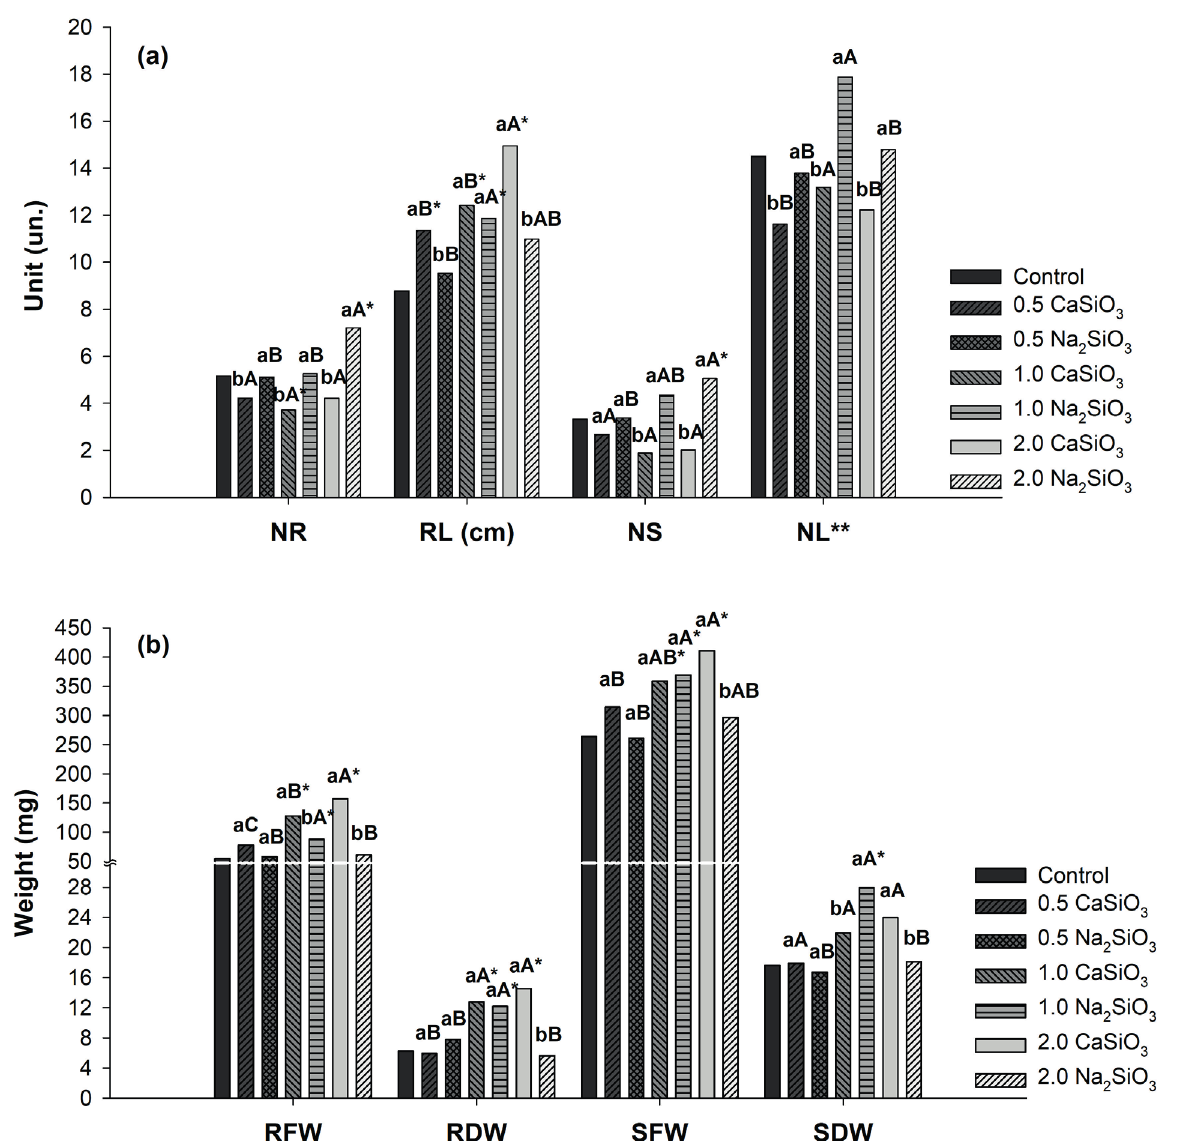
Figure 2 - Growth analysis in plants of B. zebrina as a function of different sources and concentrations (mg L -1 ) of silicates after 100 day of in vitro growth. (a) Number of roots (NR), root length (RL) in cm, number of shoots (NS) and number of leaves (NL); (b) Root fresh weight (RFW), root dry weight (RDW), shoot fresh weight (SFW) and shoot dry weight (SDW) in mg. Means followed by ‘*’ are different from the control by Dunnet’s multiple range test at 5% probability; lowercase letters refer to the unfolding of the sources within each concentration, the means with distinct lowercase letters are different by Tukey’s multiple range test at 5% probability; Capital letters refer to the unfolding of concentrations within each source, the means with distinct capital letters are different by Tukey’s multiple range test at 5% probability. ‘**’ Indicate no significant statistical interaction between the sources and